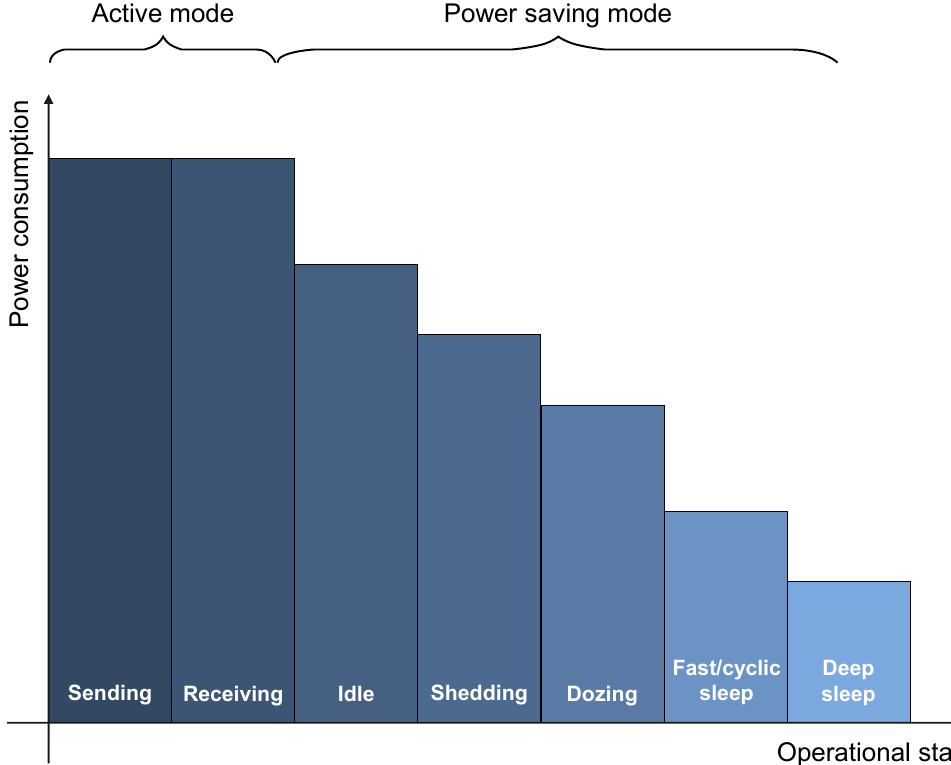
Figure 3. ONU power consumption under different active and energy-saving states.